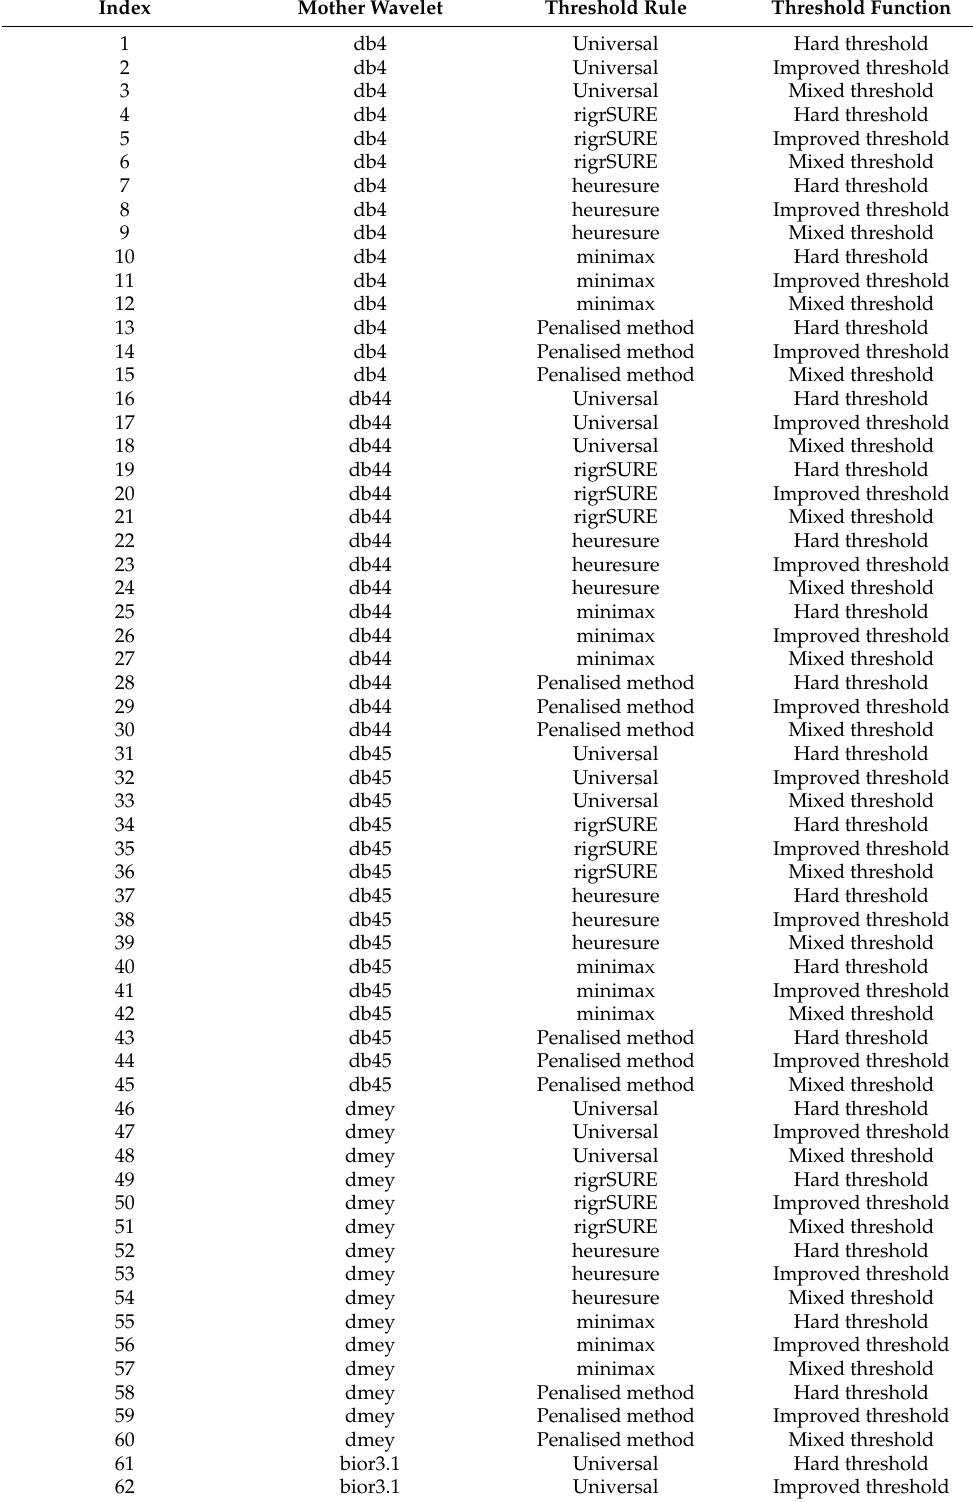
Table A1. Correspondence between indices and groups of DWT parameters: mother wavelet, threshold rule, and threshold